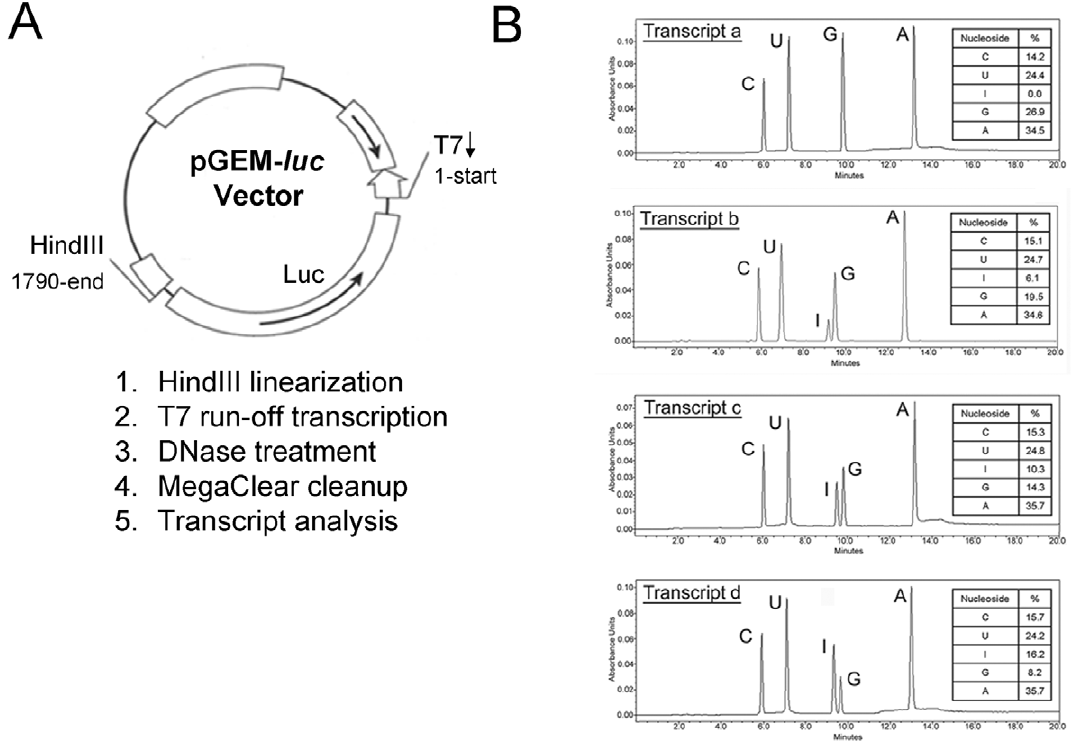
Figure 1. Invitro transcription of inosine-containing RNA. RNA was synthesized using Megascript in vitro transcription assay (Ambion, Austin, TX, USA) and pGEM-Luc vector ( panel A ) as template (Promega, Madison, WI). For RNA with inosine content, inosine tri-phosphate (Sigma, St. Louis, MO, USA) was added to the reaction mixture. Panel B , to quantify incorporation of inosines, RNA was digested by phosphodiesterase and was then separated by HPLC. Relative nucleoside incorporation was determined by calculating the area under each peak. The synthesized RNA is 0% (a), 6% (b), 10% (c) or 16% (d) inosines incorporations.